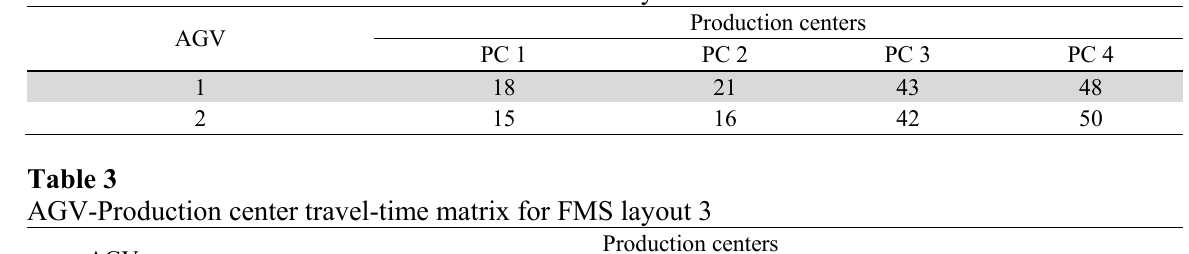
AGV-Production center travel-time matrix for FMS layout 2